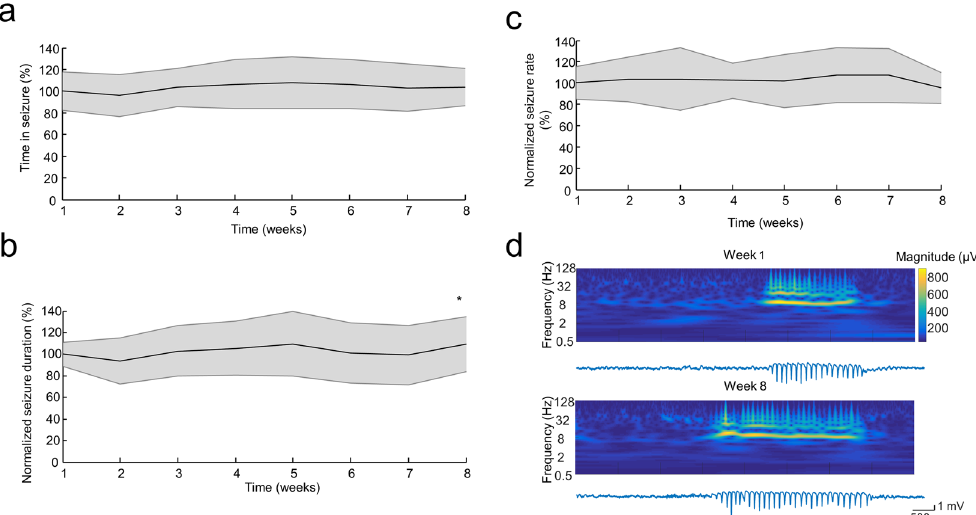
Figure 3. Seizure characteristics and signal quality of the non-treated animals. (a,b and c) Group data shows the Time in Seizure ( a ), average seizure duration ( b ) and seizure rate ( c) over the weeks of observation (each measure is normalized to its corresponding mean ‘Week 1’ value for each animal). Shaded area represents ± SD. ( d) Example LFP traces and continuous wavelet spectra of the recordings of one representative rat demonstrating the stable signal quality over the weeks. * p < 0.01 vs Week 2 , one-way ANOVA ( a,c ), Kruskal- Wallis test ( b ), both followed by post hoc